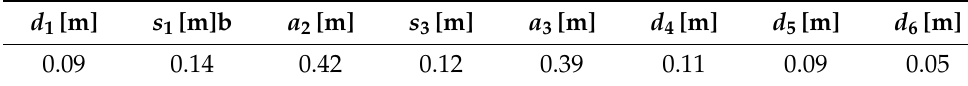
Figure 1. Kinematic chain for the UR5 robot. Table 1. Kinematic parameters for the UR5